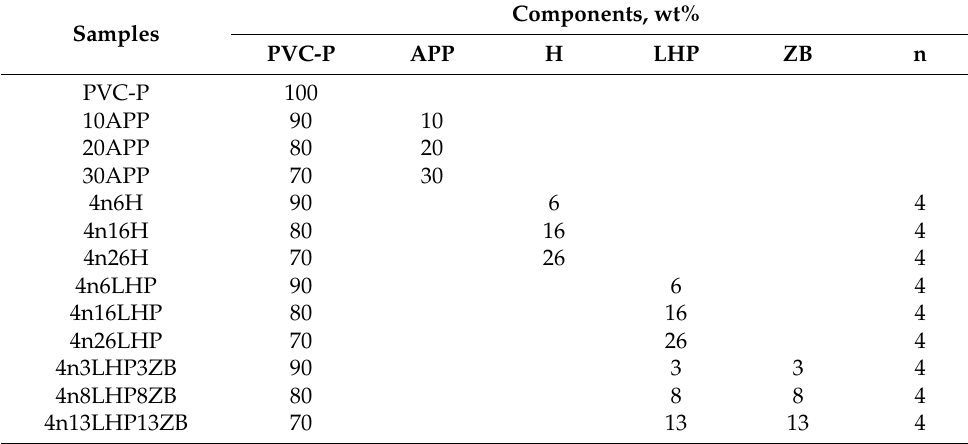
Table 1. Formulations of PVC-P compounds with various types of fire retardants (FRs).